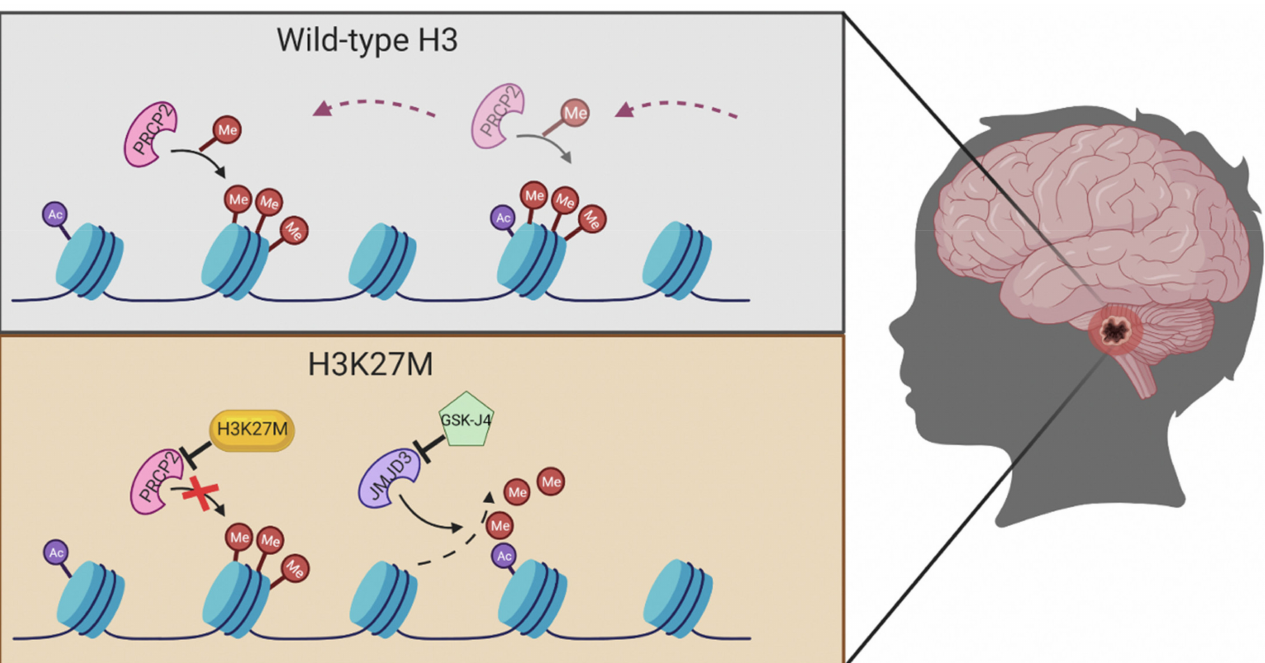
Figure 4. Significance of H3 K27M . Overall, 80% of all DIPG exhibit a missense mutation at histone H3 K27M . This mutation is a substitution of lysine with methionine in the position 27 (K27M). Histone H3 is a checkpoint control of transcriptional regulation in the synthesis phase of DNA. When mutated, H3 K27 trimethylation is ablated resulting in a repression of the polycomb repressive complex 2 target genes, which can lead to chromatin disaggregation and cellular aneuploidy. The prognosis for these H3 K27M -mutant pediatric gliomas is very poor and universally fatal. Image created with